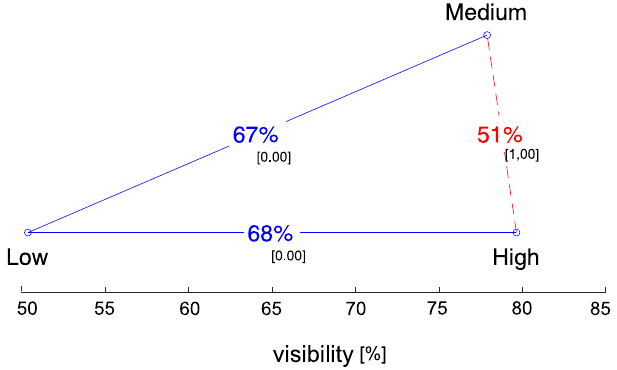
Figure 7. Average visibility results. The ranking shows the relationship between the groups with respect to contrast. Each blue circle represents a tested condition and they are ordered according to their ranking, with the least preferred condition on the left. The x-axis represents the rating of each condition, expressed as the mean number of votes, i. e. mean visibility of the disks with given setup. The percentages indicate the probability that an average observer will regard the condition on the right as better than the condition on the left. If the line connecting two conditions are red and dashed, there is no statistical difference between this pair of conditions ( H 0 could not be rejected at 0.05 level). The small-font number in square brackets indicates the p value of the t test between both conditions (without compensation for multiple